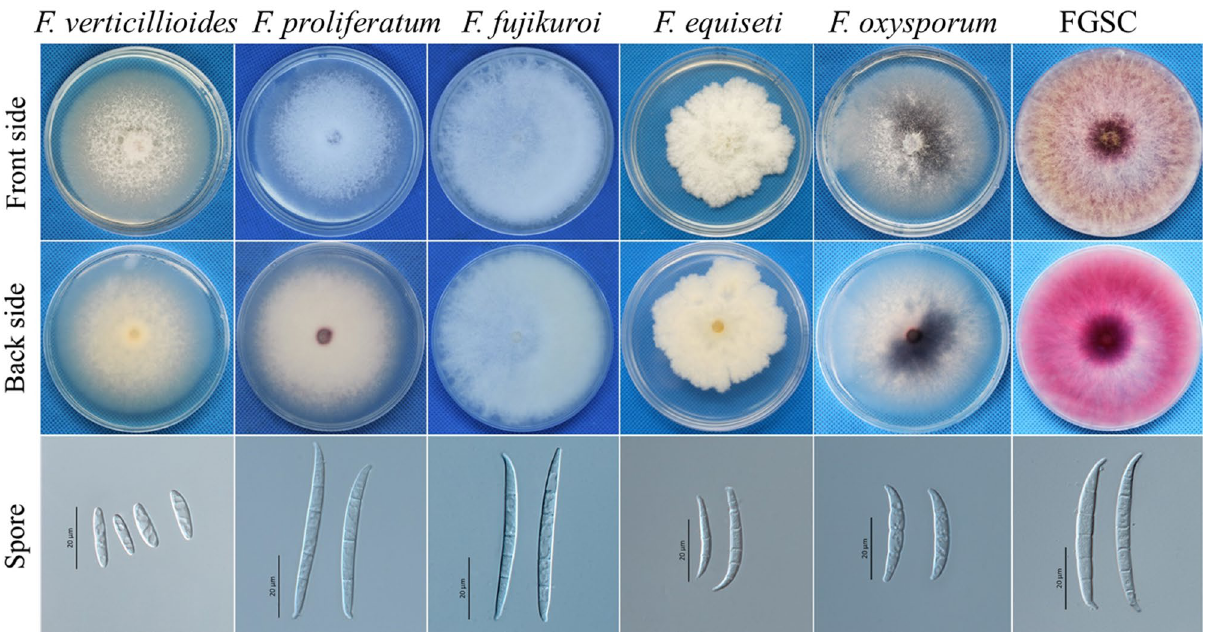
Figure 3. Representative colonies formed on PDA and conidial morphology characteristics.